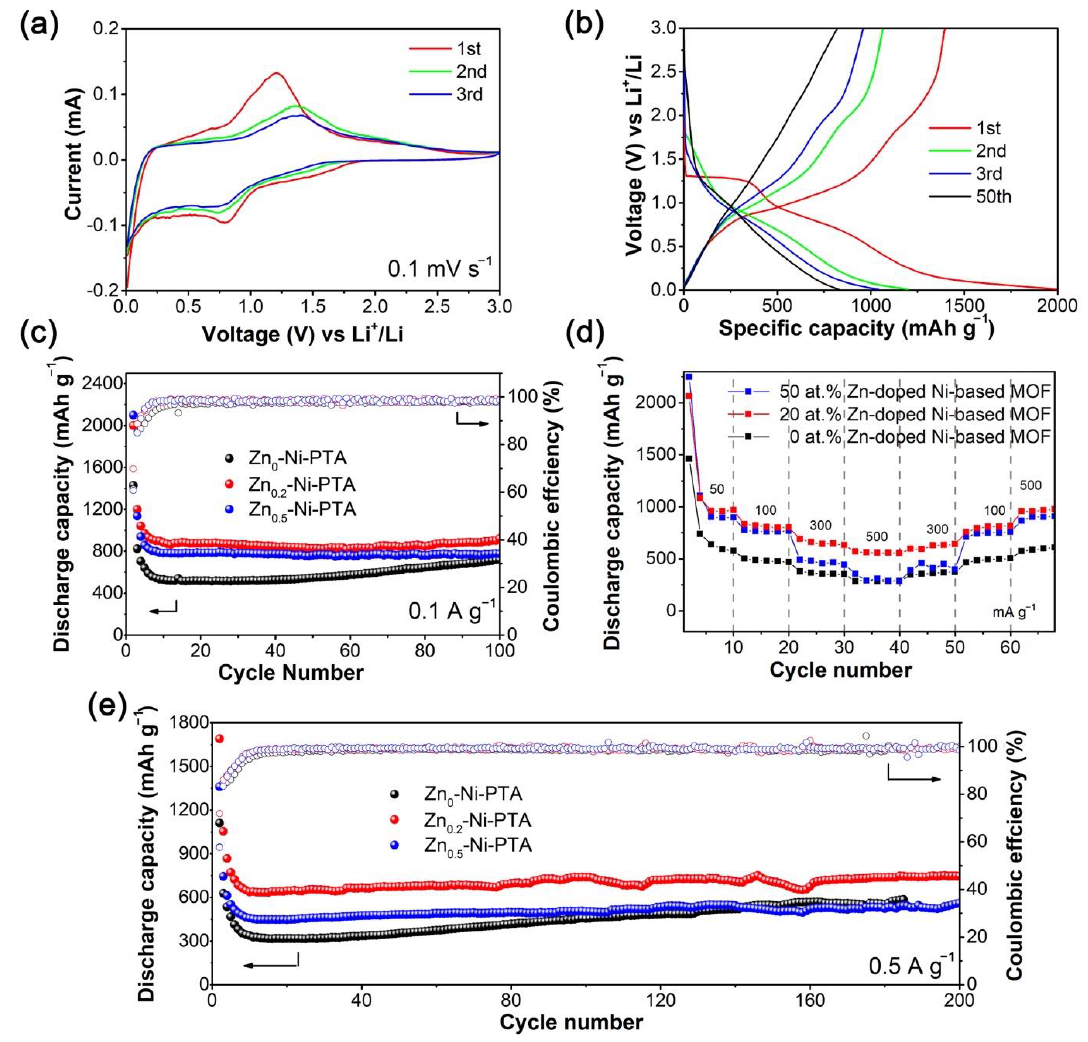
Figure 3. Electrochemical performance of Zn x -Ni-PTA material: ( a ) CV curves and ( b ) voltage profiles of 20% atom fraction Zn-doped Ni-PTA. ( c , e ) Cycle and ( d ) rate performance of different MOFs. The cycle performance of different amounts of Zn-doped Ni-PTA at the current den- sity 0.1 A g −1 and 0.5 A g −1 is displayed in Figure 3c,e. The 20% atom fraction Zn-doped Ni-PTA delivers the initial discharge capacity of 2000 mA h g −1 at 0.1 A g −1 and 1690 mA h g −1 at 0.1 A g −1 /0.5 A g −1 , respectively, with a Coulombic efficiency of nearly 100%. We